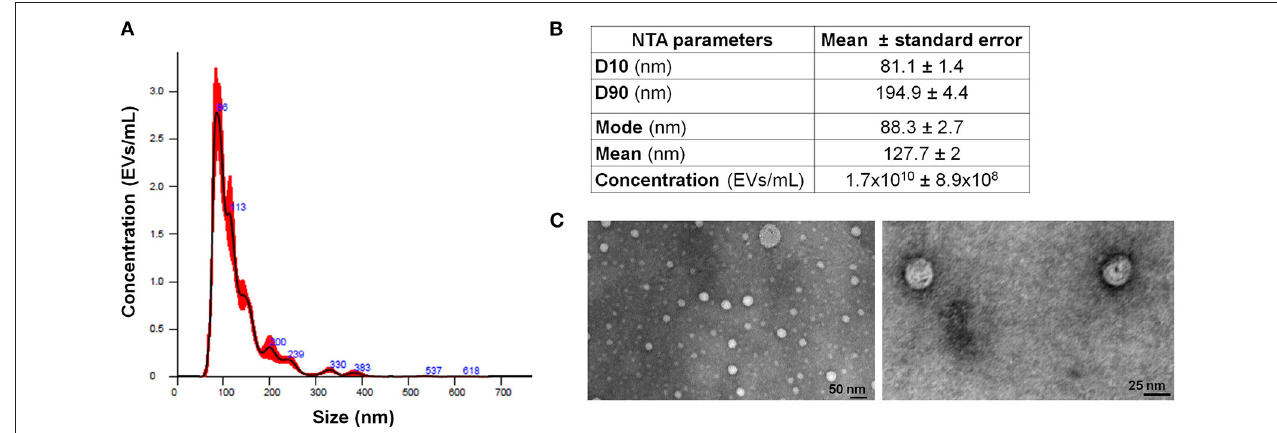
FIGURE 1 | MM-EV characterization. (A) Representative histogram of hydrodynamic EV size distribution profile from RPMI 8226 cell line measured by NTA. (B) NTA data are expressed as D10, D90, mode, mean, and concentration of MM-derived EVs as mean value ± Standard Error. (C) Representative photos of MM cell line-derived EVs obtained by TEM (image magnification: 100 and 160 KX, respectively). The horizontal bar indicates 50 and 25nm, respectively. MM, multiple myeloma; EVs , Extracellular vesicles; NTA, Nanoparticle Tracking Analysis.